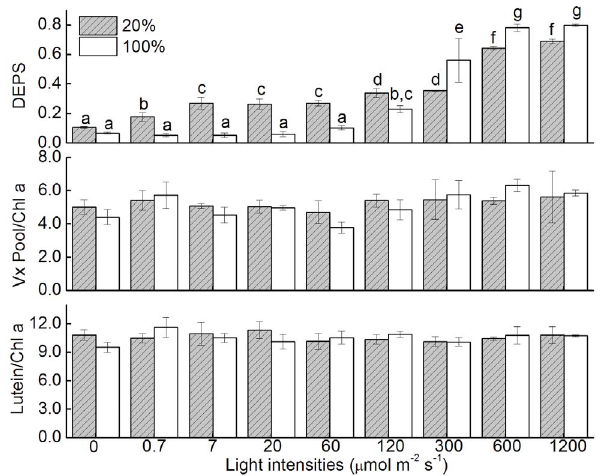
Figure 4. Linear correlations between non-photochemical quenching (NPQ) and the de-epoxidation state (DEPS) in desiccated and in fully hydrated thalli of U.pertusa . Experimental conditions were as in Fig. 3. Vertical and horizontal bars represents SD for n=3.